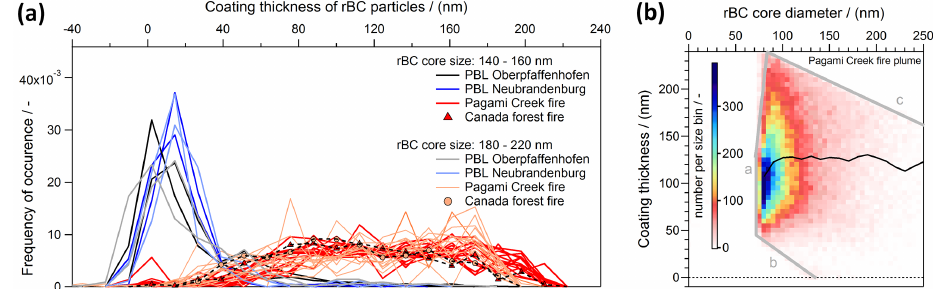
Figure 7. (a) Histograms of the coating thickness for 14 sequences (see Fig. 2) inside the Pagami Creek fire aerosol layer (red) and for fresh boundary layer aerosols in Oberpfaffenhofen, near Munich, and Neubrandenburg in black and blue, respectively, for rBC cores sizes of 140–160nm (intense color) and 180–220nm (light color). (b) The relationship between rBC core diameter and coating thickness for all 14 sequences in the forest-fire aerosol layer is shown as color-coded 2-D histogram including the median coating thickness (black line). The methodological boundaries are indicated by grey lines (a: rBC core below BID lower detection limit; b: scattering signal below LSD lower detection limit; c: scattering signal above LSD higher detection